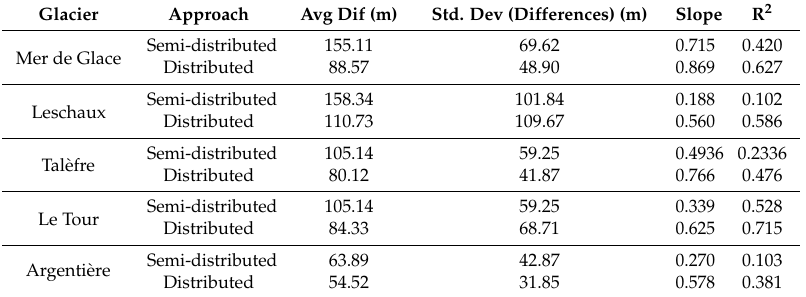
Table 9. Average differences, standard deviations, slope of the linear adjustment, and R 2 values for the observed and simulated ELA five glaciers of the study